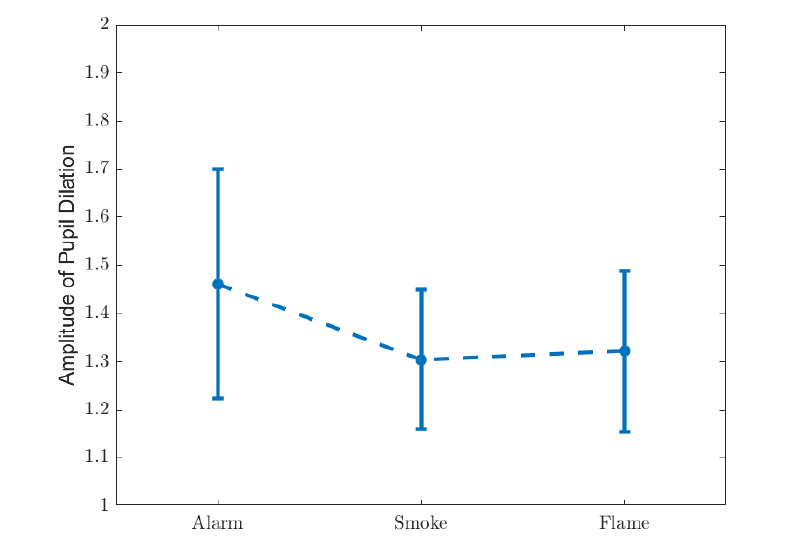
Figure 10. Amplitude of pupil